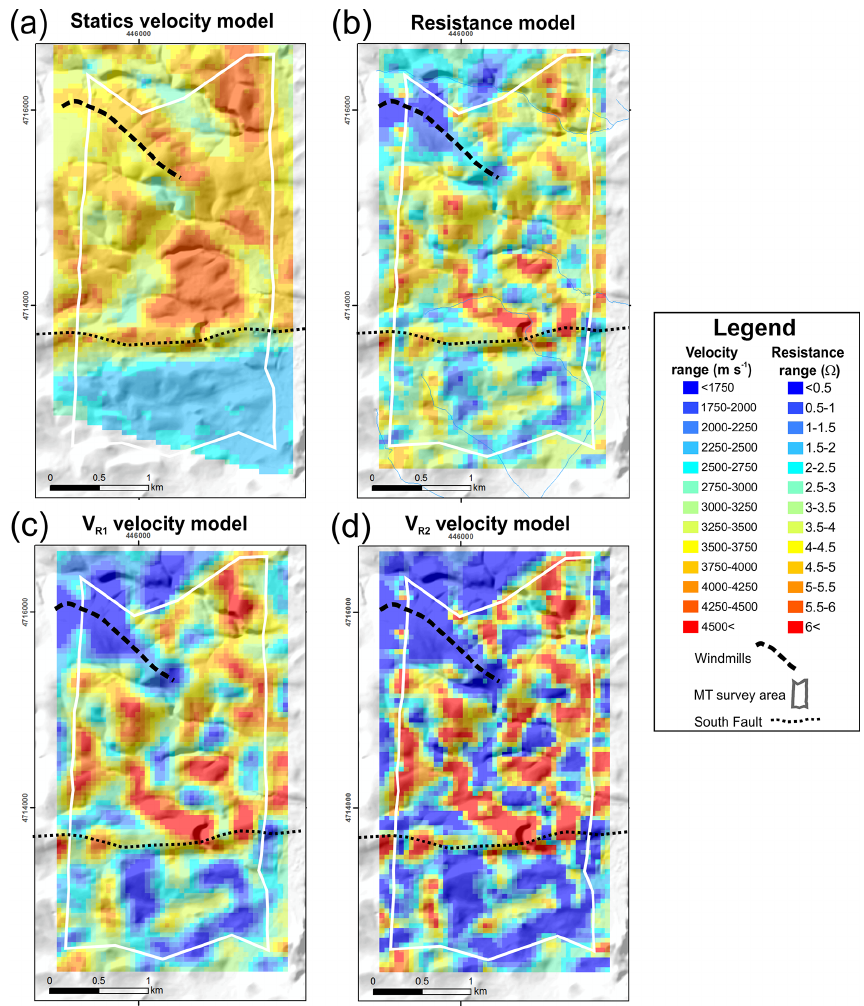
Figure 10. Static corrections model from seismic (a) , resistance model for the first 40m (b) and replacement velocity model for the first 40m computed using V R1 (c) and V R2 (d) . Black dashed lines indicate the windmill line and the centre of the area with low-quality